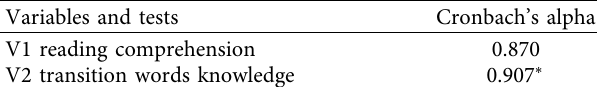
Table 4: Cronbach’s